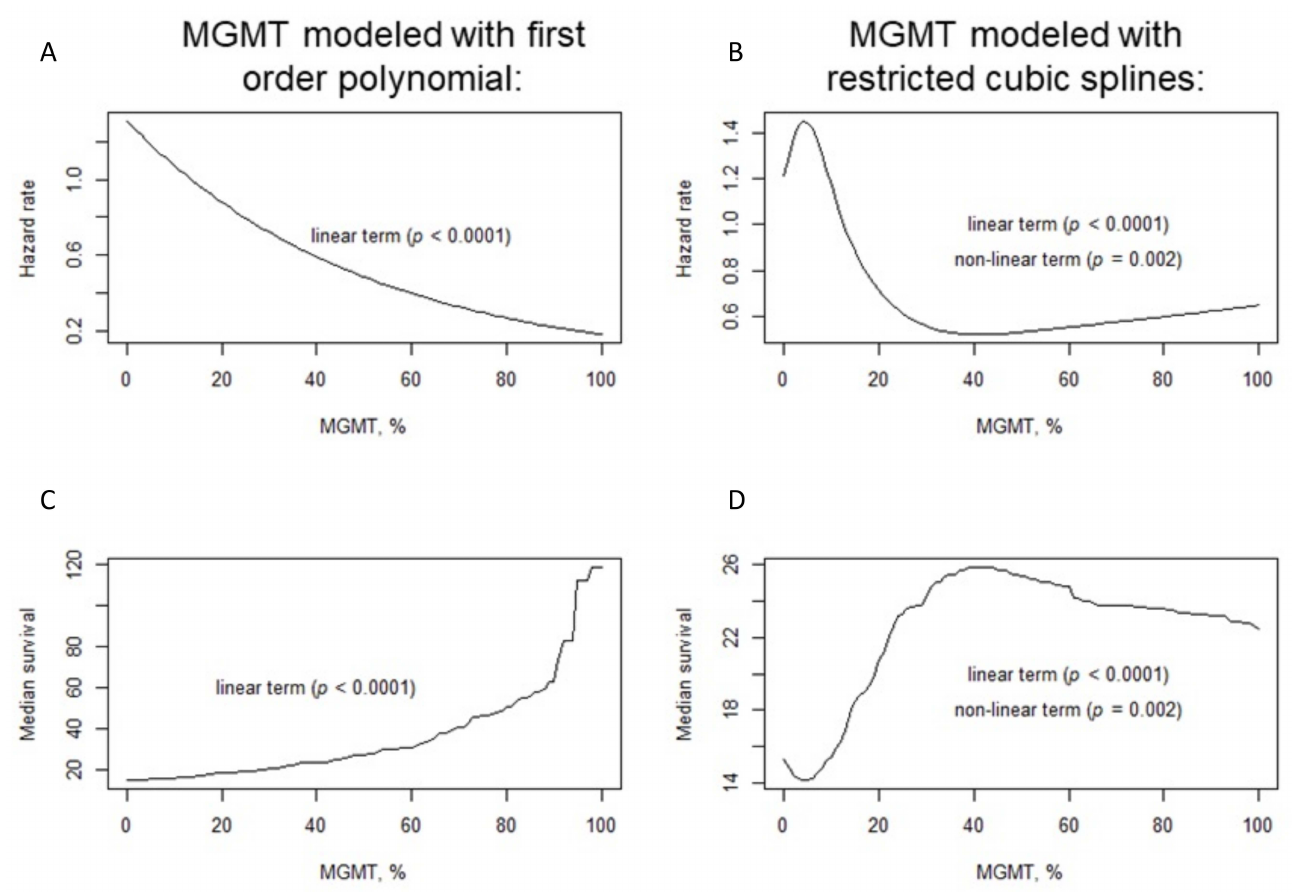
Figure 4. Hazard ratio according to MGMT promoter methylation under the assumption of lin- ear association ( A ) or non-linear association ( B ); median survival according to MGMT promoter methylation under the assumption of linear association ( C ) or non-linear association ( D